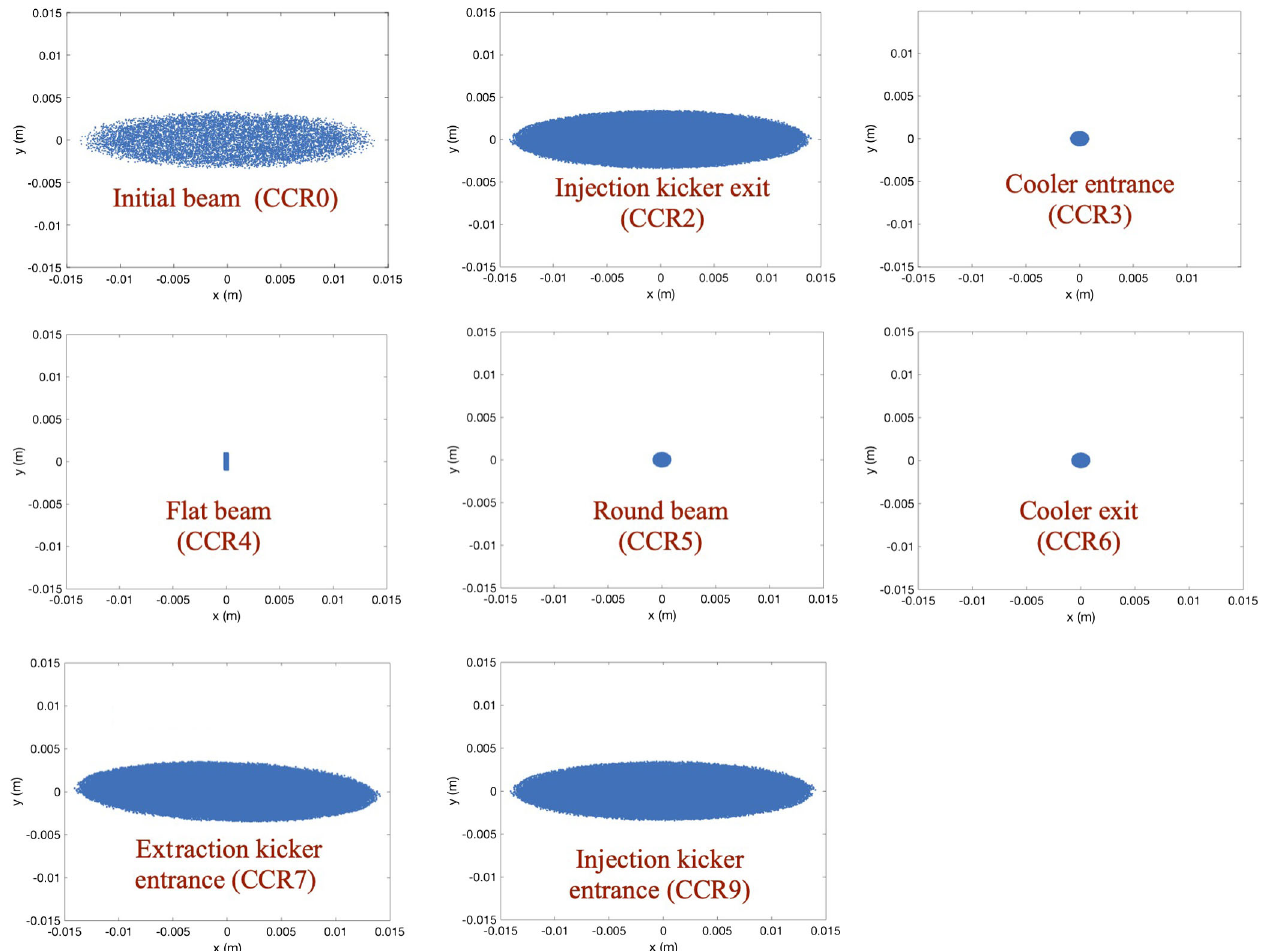
FIG. 12. The transverse ( x − y ) profiles of the magnetized beam around the CCR without kickers. The profiles were overlapped over 11 passes and they are close to single pass profiles due to stable beam